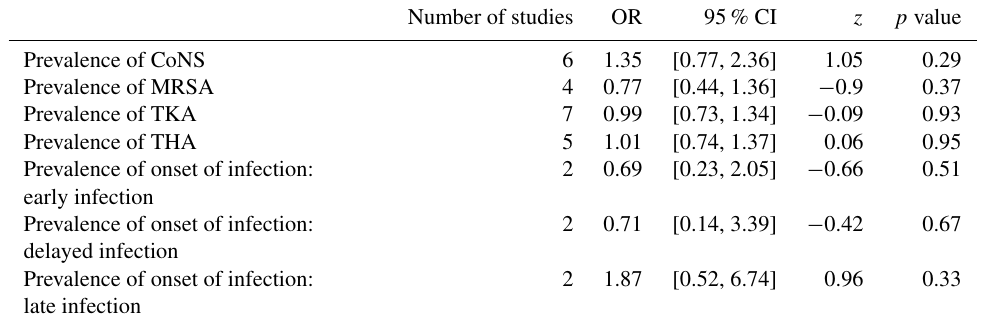
Table 5. Baseline variables in patients receiving short-duration (experimental) and long-duration (control) IV antibiotic treatments for